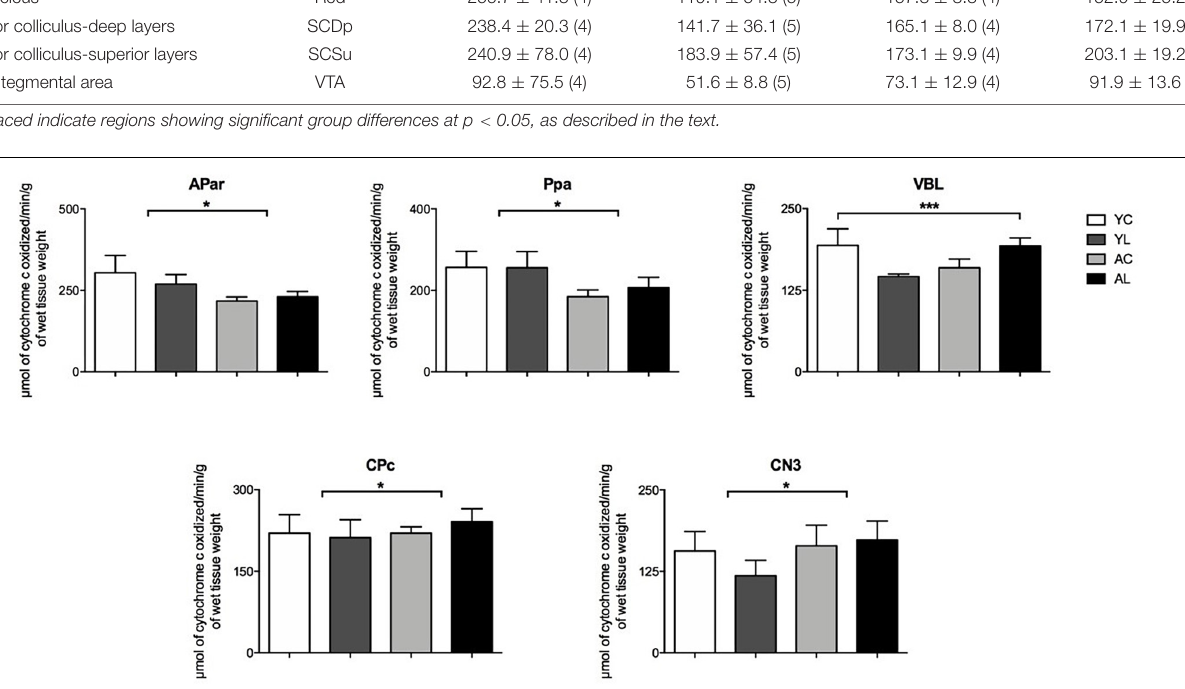
FIGURE 3 | Sensorimotor system. Significant CCO activity group differences in the APar, Ppa, VBL, CPc, and CN3 in rats from young laser (YL; n = 5), young control (YC; n = 7), aged laser (AL; n = 6), and aged control (AC; n = 6) groups ( p < 0.05; ANCOVA). (*) One main effect in the APar, Ppa, CPc, and CN3. (***) Interactions of age and treatment in the VBL. See text for